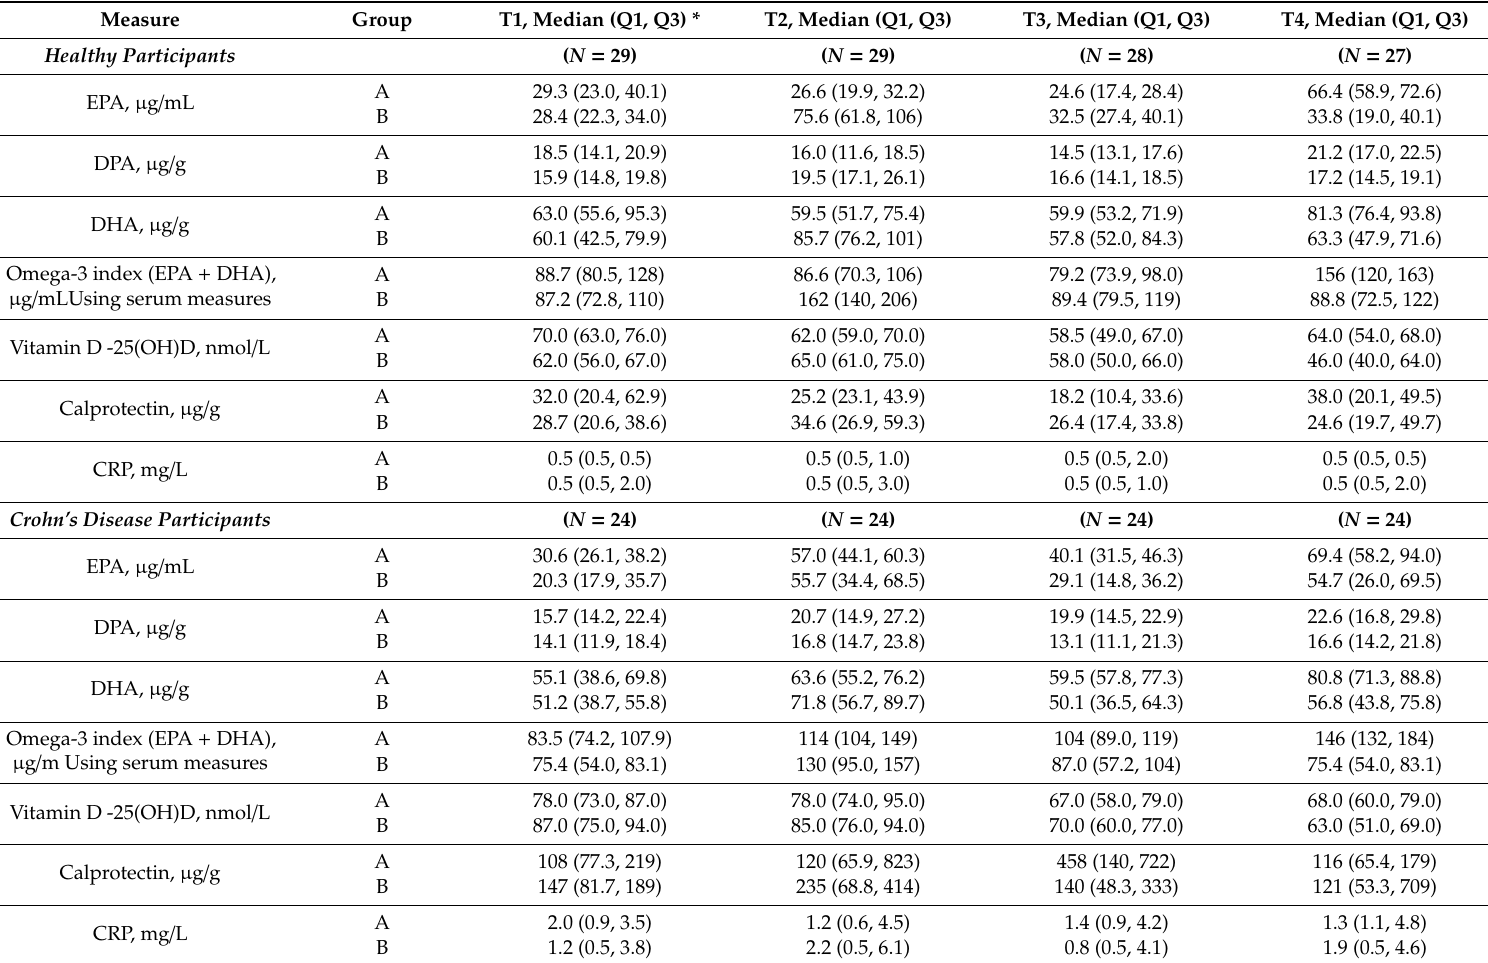
Table 3. Summary of outcome measures at each time point by group for healthy and Crohn’s disease